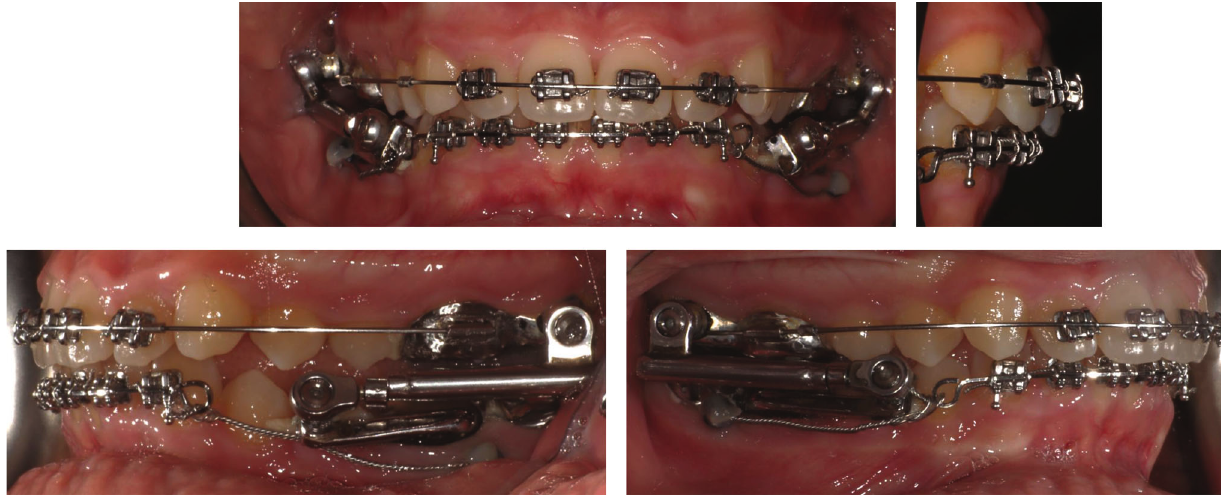
Figure 11: Herbst appliance with